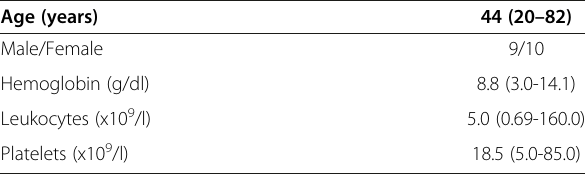
Table 3 Clinical and hematological data of the patients